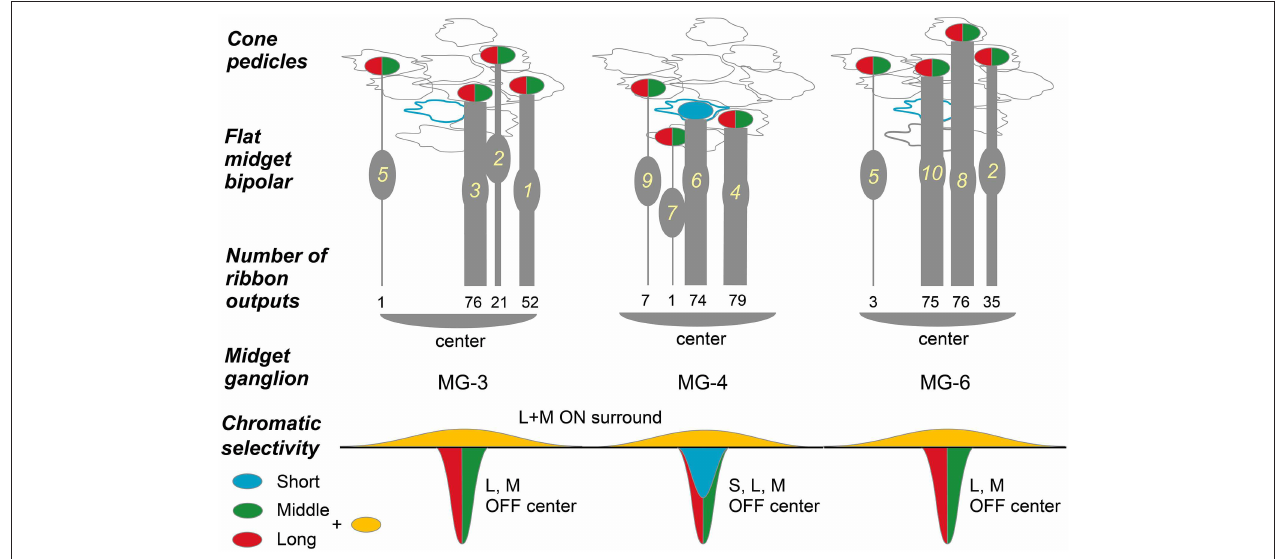
FIGURE 11 | Convergence of cones via FMB cells onto midget ganglion cells. Four cones converge onto each of three midget ganglion cells MG-3, -4, and -6 via four FMB respective cells. Ellipses colored in red and green: L- or M-cone pedicle; ellipse colored in blue: S-cone pedicle. The numbers of ribbon synapses of FMB cells (1 ∼ 10 in yellow) are provided in numerical figures and approximately expressed with the thickness of bipolar